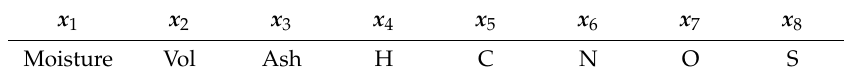
Table 1. Predictor variables in coal data set.